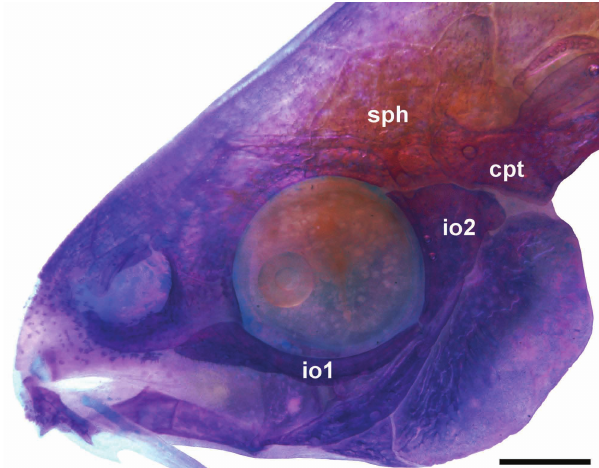
Fig. 3. Lateral view of the head of a cleared-and-stained specimen of Corydoras guapore , ZUFMS-PIS 4000, 28.8 mm SL. Abbreviations: io1: infraorbital 1, io2: infraorbital 2, sph: sphenotic, cpt: compound pterotic. Scale bar = 1 mm.